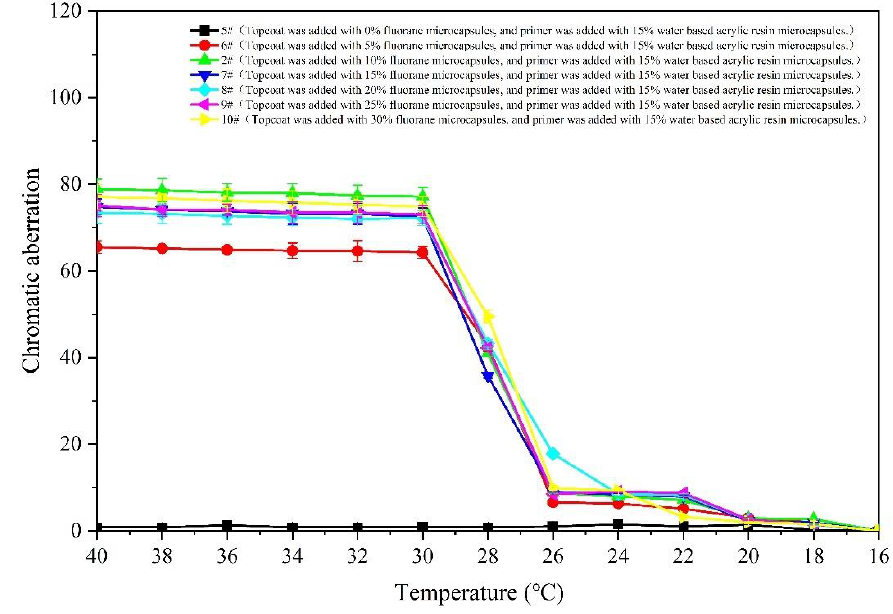
Figure 8. The influence of cooling on color difference of coating.